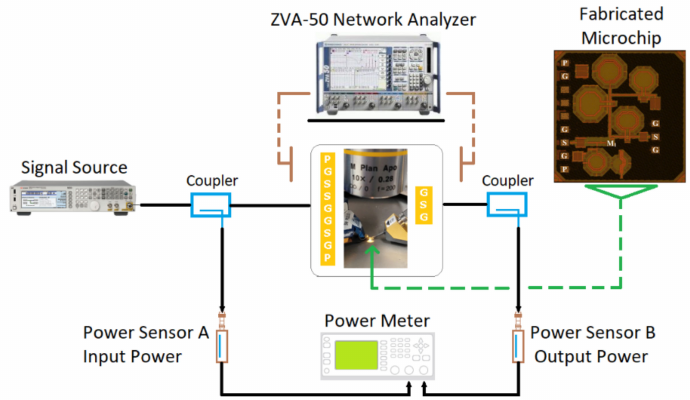
Figure 5. Chip photomicrograph of the fabricated 65 nm CMOS Class-F − 1 PA and Cascade Microtech Summit 11K Probe-Station test set-up.